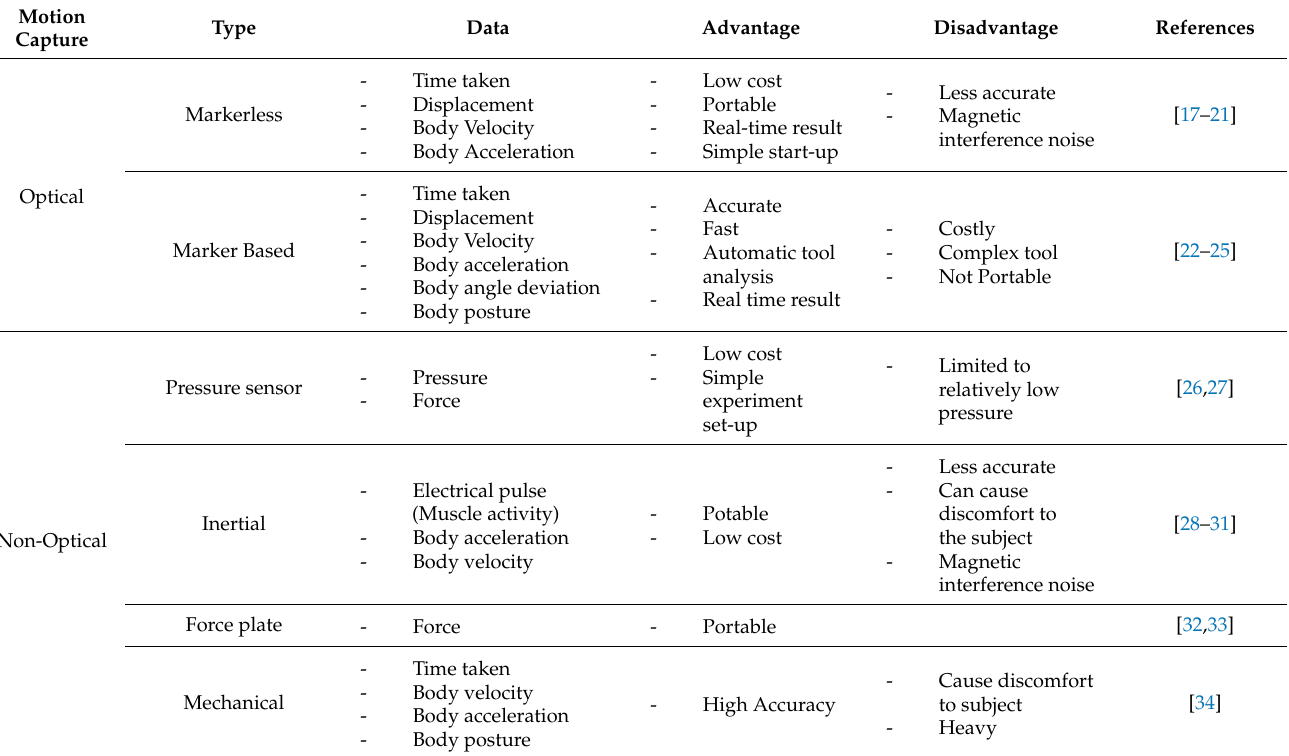
Table 1. Advantages and limitations of motion capture systems in determining ergonomic risk assessment. Motion Data Advantage Capture